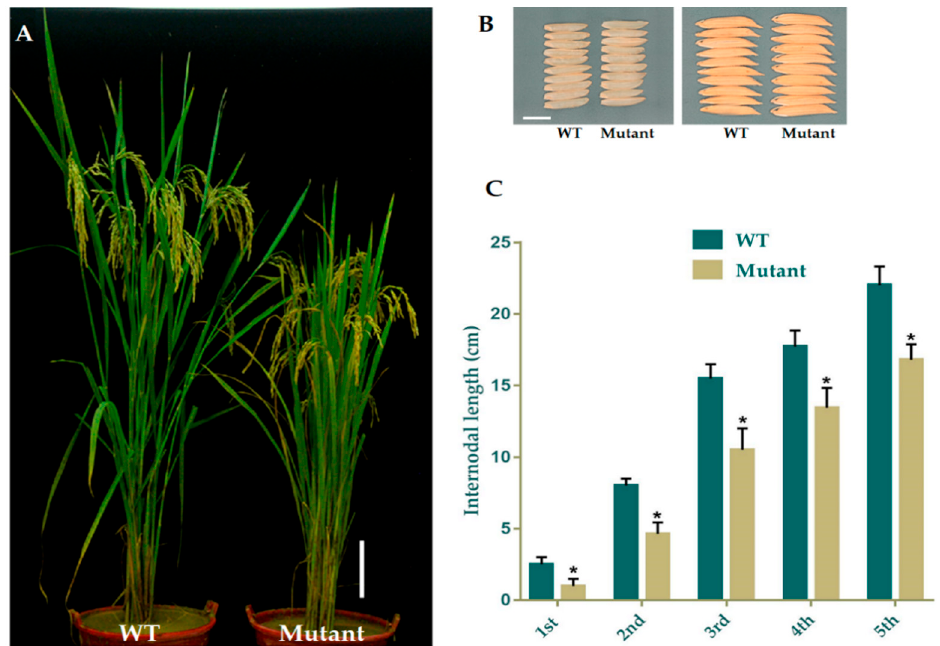
Figure 2. Phenotypic appearance of OsGA20ox2 in GXU43_9 and WT. ( A ) Plant height of mutant lines and WT after the heading stage. Bar = 15 cm. ( B ) Grain phenotype of mutant line and WT; Bar = 5 mm. ( C ) The lengths of internodes in mutant line and WT. The “*” denotes the significant difference at p < 0.01. Values are means ± standard deviation (SD) ( n = 10 plants).